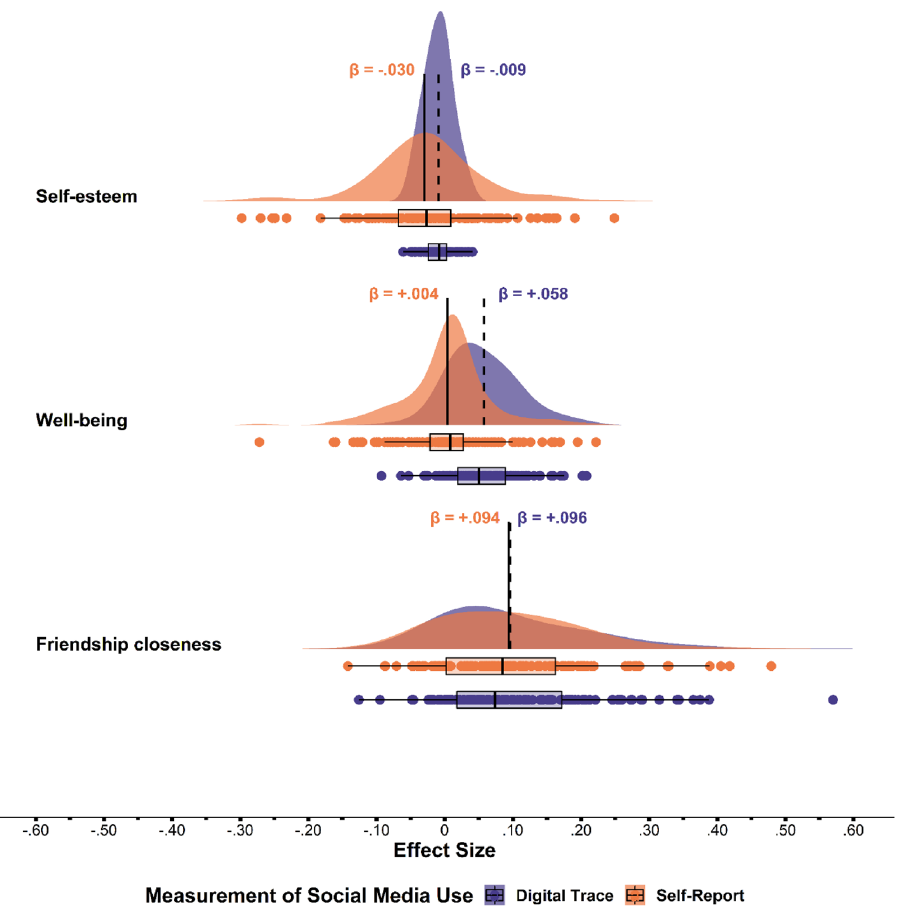
Figure 1. Distribution and overlap of the person-specific effects of time spent on social media (TSM) according to the self-reported and digital trace measure on self-esteem (top), well-being (middle), and friendship closeness (bottom). Note. Standardized effect sizes are displayed on the x -axis, the type of psychosocial functioning on the y -axis. The dots below the distribution plots represent the person-specific effects of each adolescent. The vertical solid and dashed black lines represent the overall within-person effects for the self-reported measure (solid) and the digital trace measure